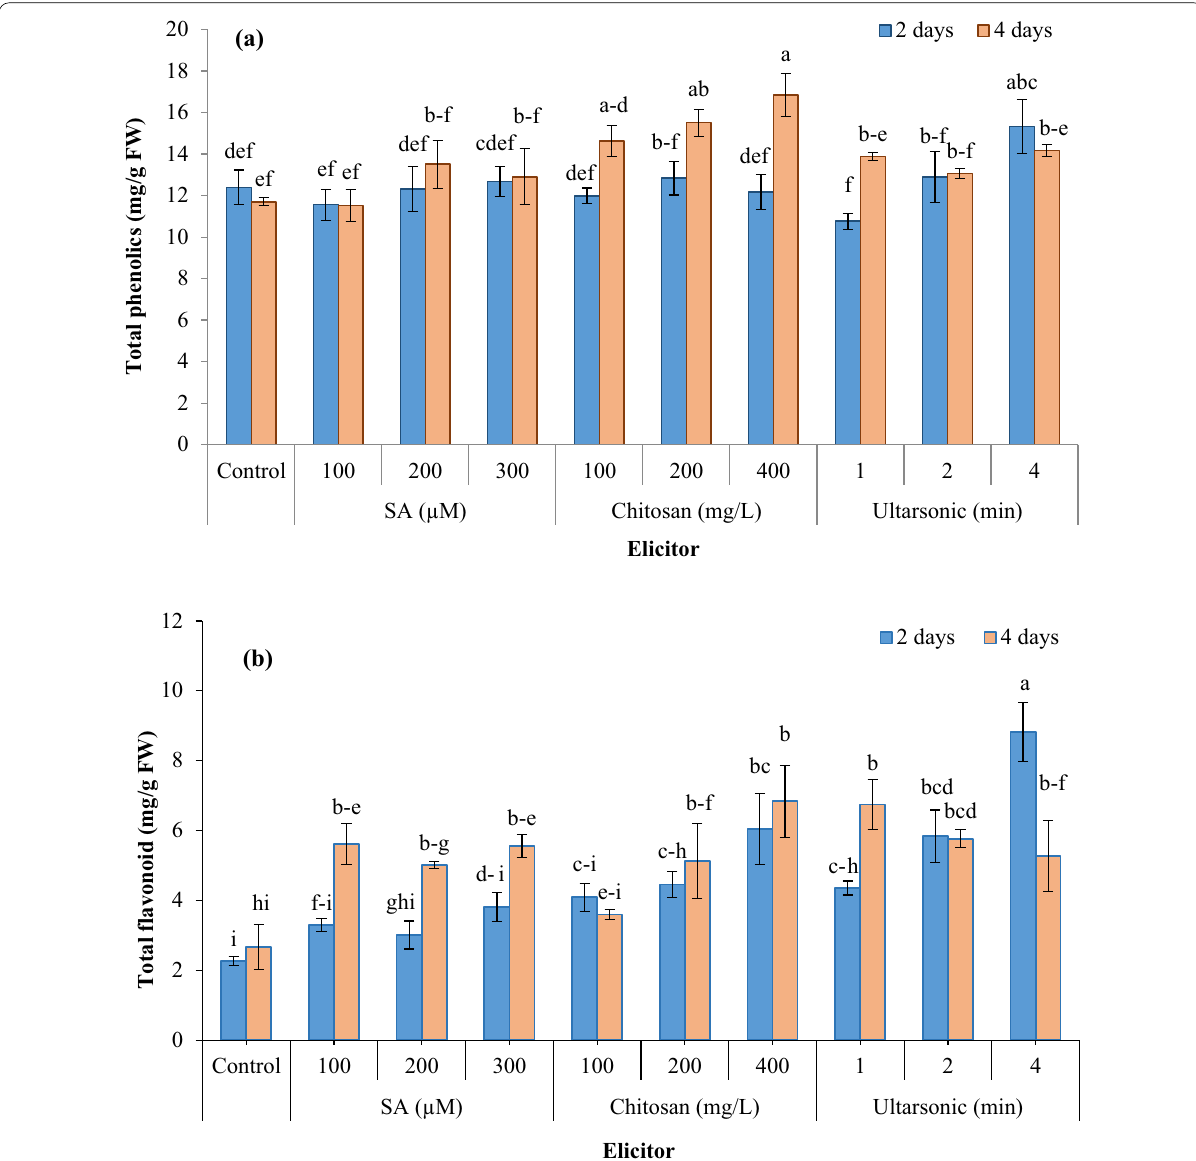
Fig. 7 Effect of different elicitors on total phenol ( a ), and total flavonoid ( b ) in hairy roots of G. officinalis . Different letters show significant differences ( p < 0.01) among